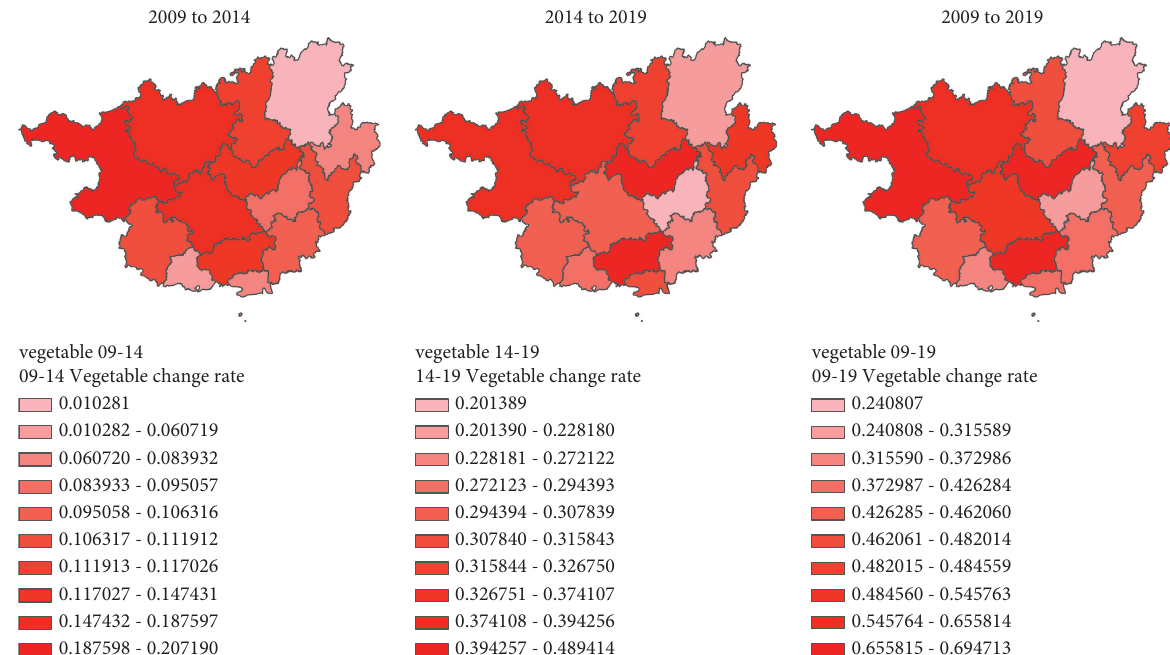
Figure 9: Change rate map of proportion of vegetable planting area in Guangxi from 2009 to